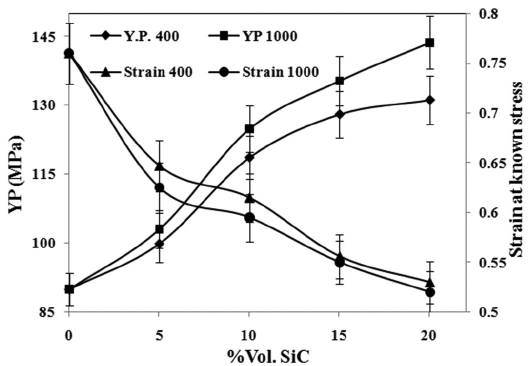
Figure 5. Yield point and strain under known stress (585 MPa) of hot extruded Al-SiC composites from compression experiments.